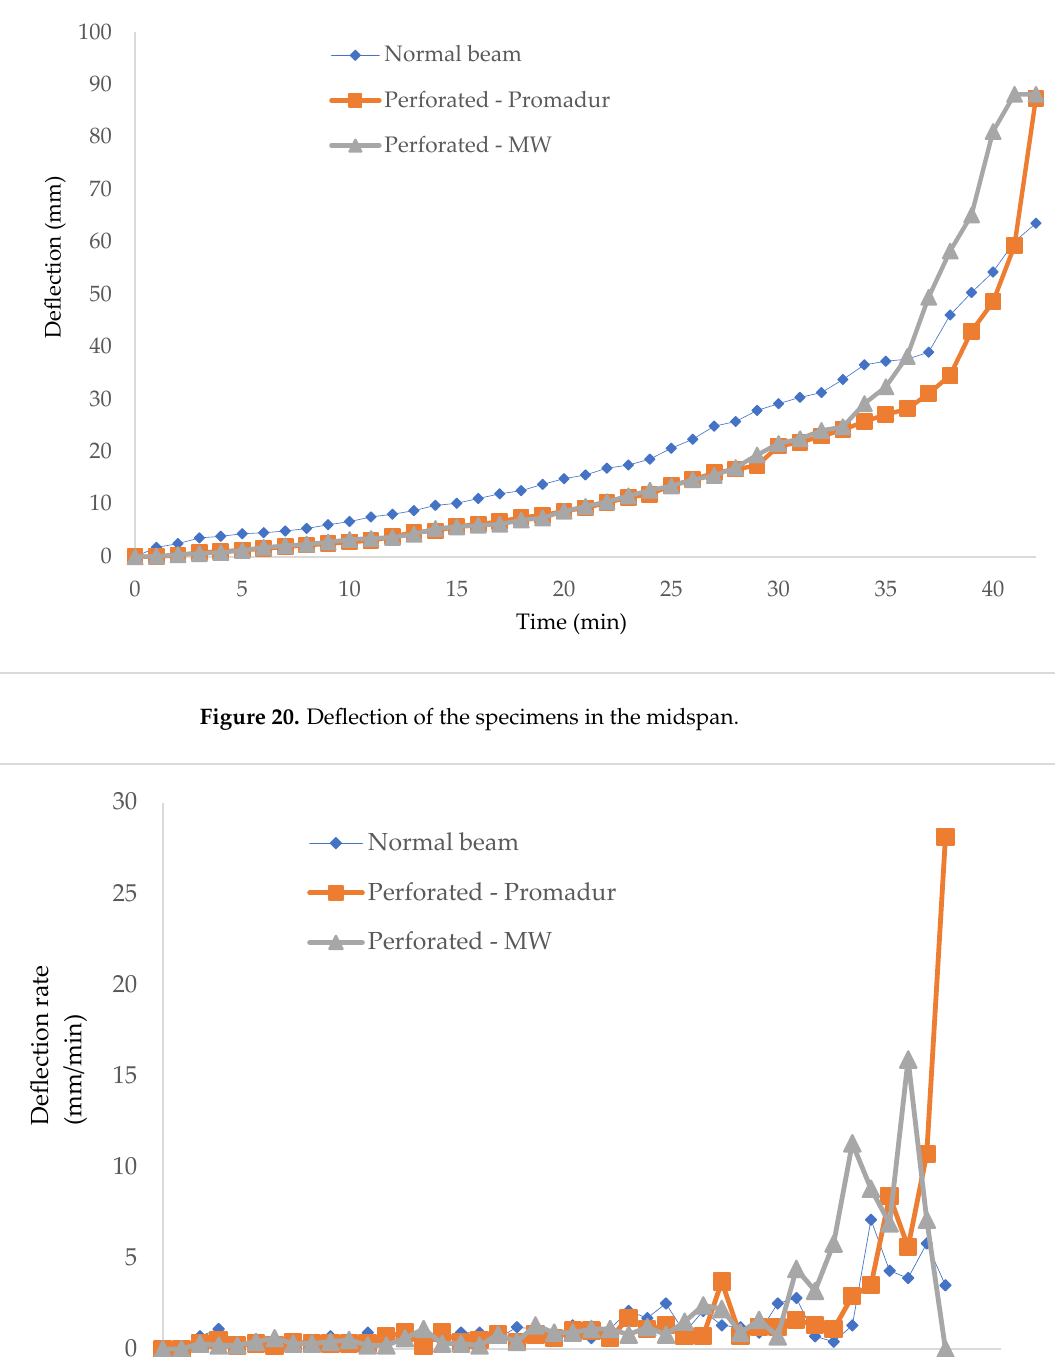
Figure 21. Deflection rate.